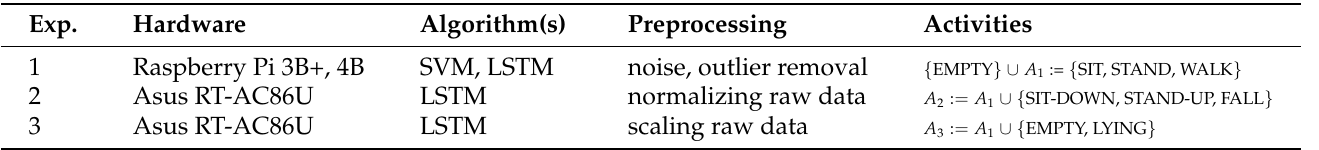
Table 1. Experiments